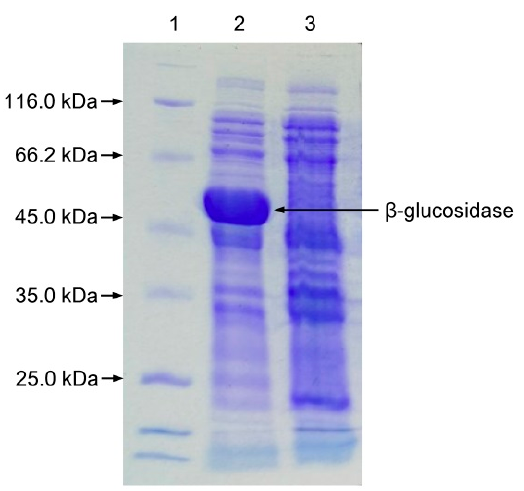
Figure 3. SDS-PAGE analysis of the recombinant β -glucosidase expressed in E . coli BL21(DE3). Lane 1, molecular weight marker; lane 2, total protein of E . coli BL21(DE3) harboring the recombinant blgS in pET28a (+); lane 3, total protein of E . coli BL21(DE3) harboring empty pET28a (+) as a negative control.